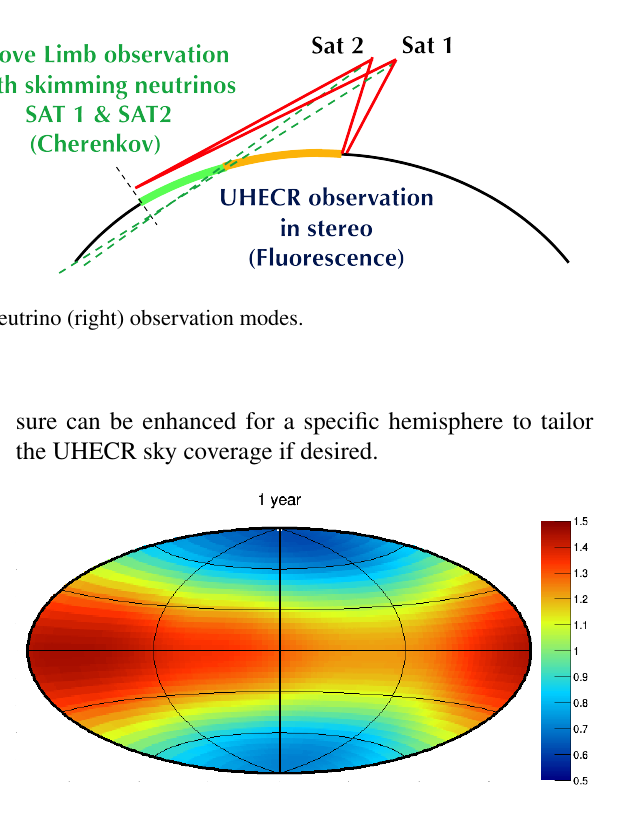
Figure 9. POEMMA’s UHECR sky exposure, in declination ver- sus right ascension for one year with the color scale denoting the exposure variations in terms of the mean response. The cal- culation takes into account the e ff ects of the sun and moon on the duty cycle for observations as well as the eccentricity of the Earth’s solar orbit.